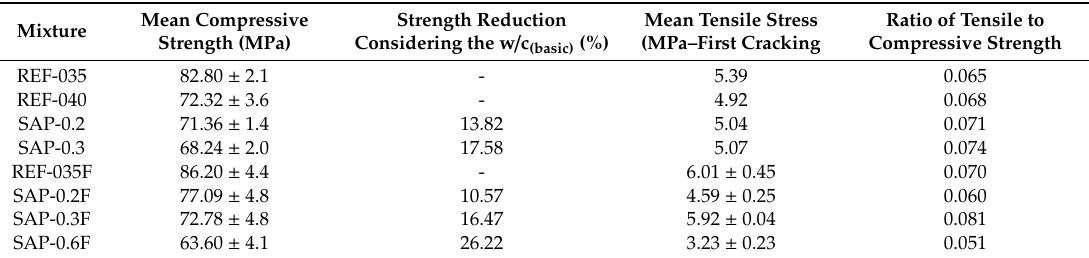
Table 3. Mechanical properties of the high strength concrete and steel fiber reinforced concrete. 240